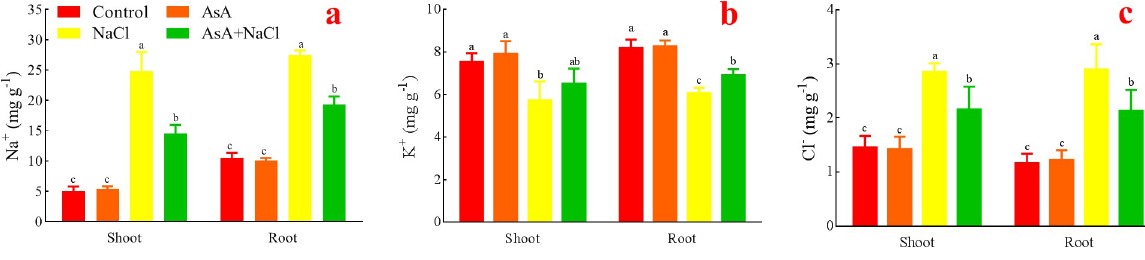
Fig 7. Effects of AsA on Na+ (a), K+ (b), and Cl �